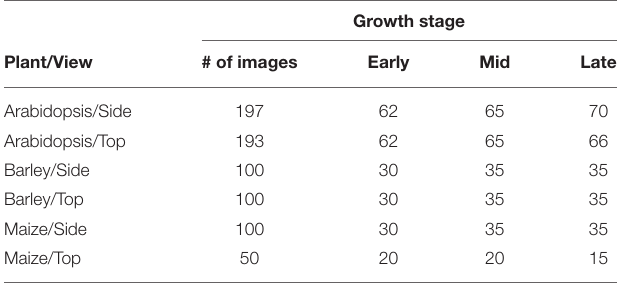
TABLE 3 | Overview of growth stages of training data from arabidopsis, barley, and maize plants.